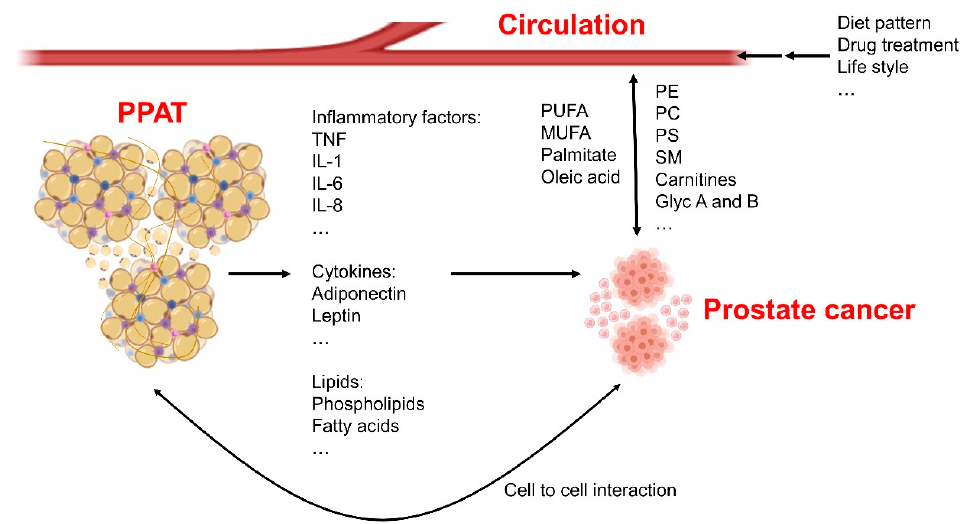
Figure 1. Systemic fatty acid metabolism changes in prostate cancer patients. The periprostatic adipose tissue (PPAT) is able to secrete inflammatory factors, cytokines, and bioactive lipids to the micro-environment of the prostate to affect growth and development of cancerous tissues. Cell-to-cell interactions also exist between adipocytes and prostate cancer cells, and these interactions contribute to cancer development. Circulating metabolites are changed because of diet patterns or lifestyles of individuals, these factors also affect cancer cells’ biology. Moreover, prostate cancer cells themselves can also secrete metabolites into the surrounding environment. Phosphatidylcholine—PC; sphingomyelin—SM; phosphatidylethanolamine—PE; phosphatidylserine—PS; poly-unsaturated fatty acid—PUFA; mono-unsaturated fatty acid—MUFA; interleukin—IL; tumor necrosis factor—TNF.